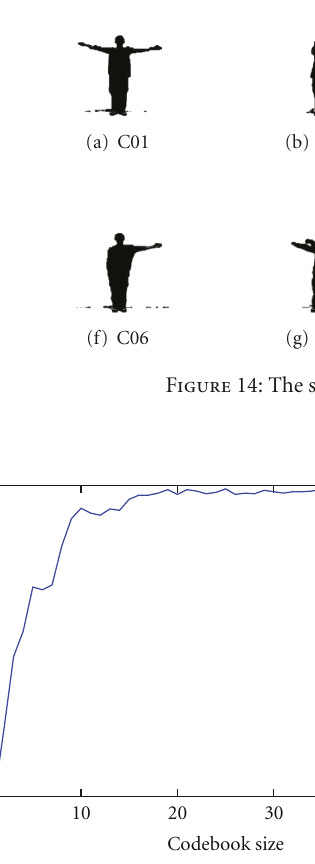
Figure 15: Recognition rates of Academia Sinica